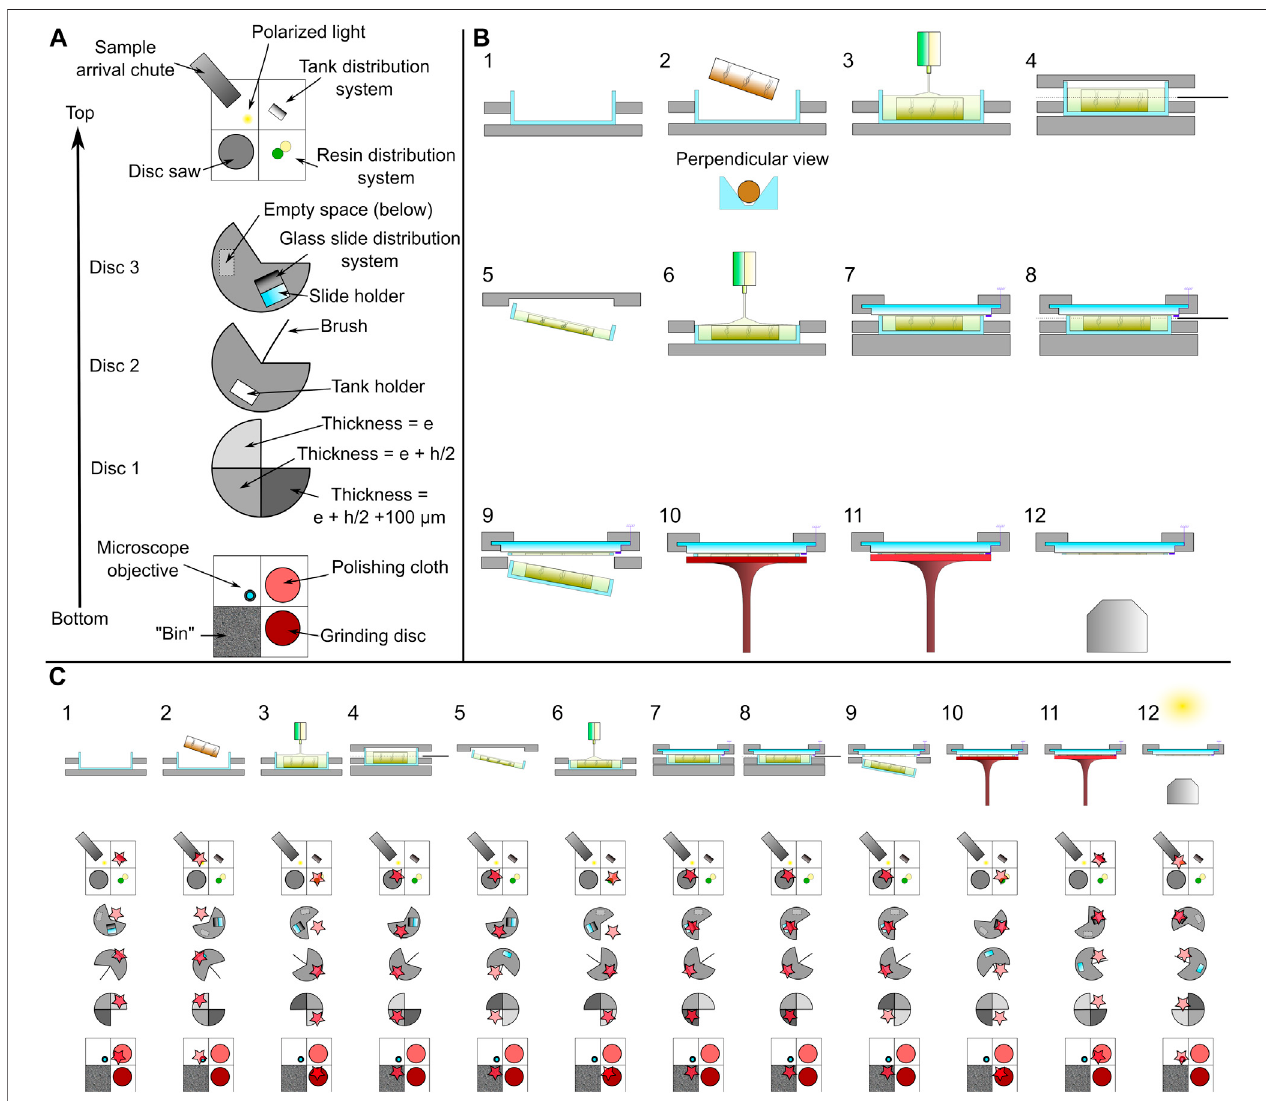
FIGURE 11 | LithoSpace system. (A) The system is composed of three superimposed discs which can rotate independently of each other. The upper part of the system is composed of the sample arrival chute, from which the drill cores arrive, the induration tank dispenser, the resin dispenser, and the sawing area with a retractablediscsaw.Theupperdisc(disc3)isonly2/3full.Itcontainstheglassslidedispenserandholder.Thereisanemptymouldonitsundersidetomaintainthetank holder during sawing. Disc2isalso 2/3 full.Ithas anotchtohold the induration tank and abrush toremove dust from the samplesurface.The lowerdisc (disc 1)is composedofanemptysectionand 3sectionsofvarious thicknessespermittingverticaldisplacementofthetank:e(typicallye (cid:2) 1 cm), e+h/2withhtheindurationtank thickness (typically h (cid:2) 1.5 cm), and e+h/2+ 100 µm.Finally,thebottom part ofthesystemiscomposed ofthemicroscope objective (orany other instrumental probe), the polishing disc, the grinding disc and the bin to store the cutting residues. (B) By moving the discs it is possible to make and observe a thin section in 12 steps as describedin (C) .1-Anindurationtankisinsertedfromthetankdistributionsysteminthededicatedholeindisc2,ontothepartofthicknesseofdisc1.2-Thethreediscs rotate to place the tank below the arrival chute from which the drill cores fall. The tanks have a triangular pro fi le in such a way that the cores necessarily fall in a centred position. 3- The three discs rotate to place the sample below the resin dispenser and the core is the covered with resin and indurated. 4- Disc 3 is positioned so that the hollowonitslowerpartisalignedwiththetankthendisc1ispositionedonthepartofthicknesse+h/2soastobringupthetankwhichthenbecomeswedgedindisc3. Finally,thetankplusthedrillcoreassemblyiscutthroughitsmiddle.5-Theassemblyturnsinordertocomeabovethe “ bin ” anddiscs2and1rotateinordertoevacuate theupperpartofthesample.6-Disc1returnstoitsstartingpositionofthicknesseinordertolowerthesample.Thethreediscsrotatetoplacethesamplebelowtheresin dispenser where resin is deposited onto the cut surface of the sample. 7- A glass slide is slid into the slide holder. Disc 1 then raises the sample half the thickness of the tankplus100 µmsothatitisgluedontotheglassslide(partofthediscofthicknesse+h/2+100 µm).8-Thesampleiscutagaintoathicknessof100 µmrelativetothe surfaceoftheglass slide.9-Thethreediscsrotatetothe “ bin ” positionanddisc3isrotatedonitsempty parttoevacuatethebottompart ofthesample.10-Thesection is ground inorder tocorrect theparallelismofthe facesand to reduce its thickness to ∼ 32 µm. Thegrindingstop iscontrolledby acircuit breaker. 11-Thethin section is polishedinordertodecrease theroughnessand toreachthe fi nalthicknessof30 µm.12-Thepolishedthinsection ispresented totheobservation/analyticalsystem(s). The position of the discs during the different steps are detailed in (C) . The stars indicate the position of the sample.